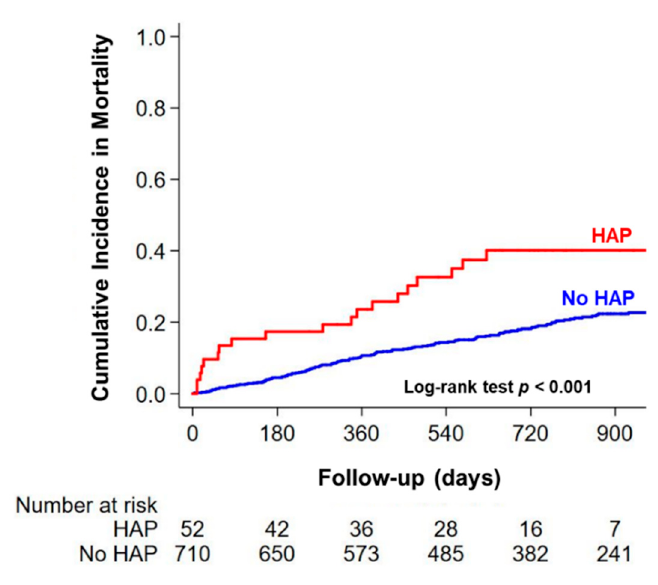
Figure 3. Kaplan-Meier analysis of all-cause death after discharge in patients with or without HAP, hospital-acquired pneumonia. Table 3. Cox proportional hazards model for determinants of all-cause death after discharge.